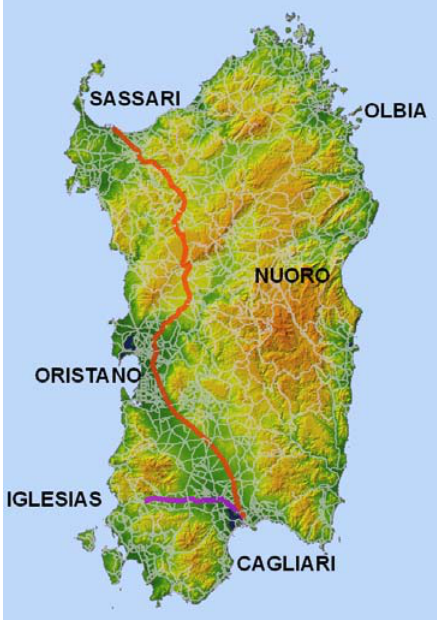
Figure 4. 3D Visualization of the main road infrastructures of Sardinia over the regional Digital Elevation Model: National Road n. 131 (in red) and n. 130 (in violet). Source: Centro Interregionale